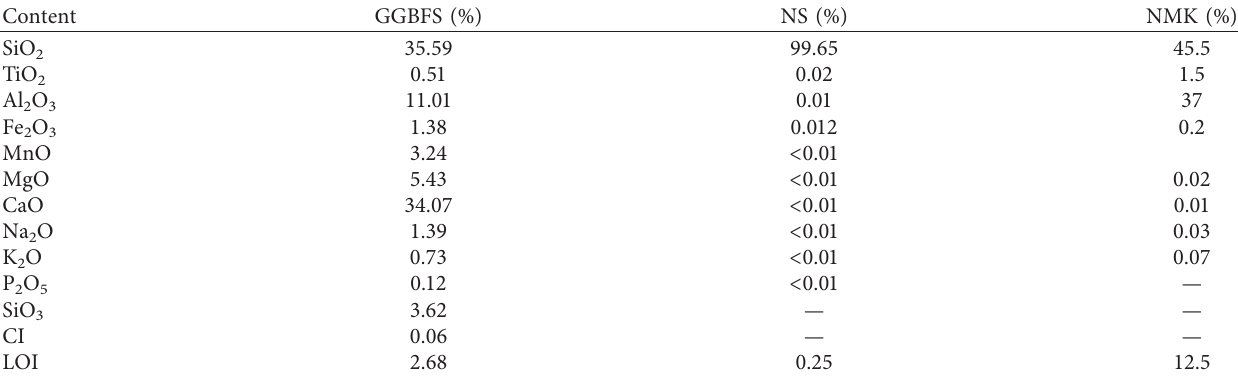
Table 1: Physical properties and XRF analysis results of fly ash, slag, and nanosilica.